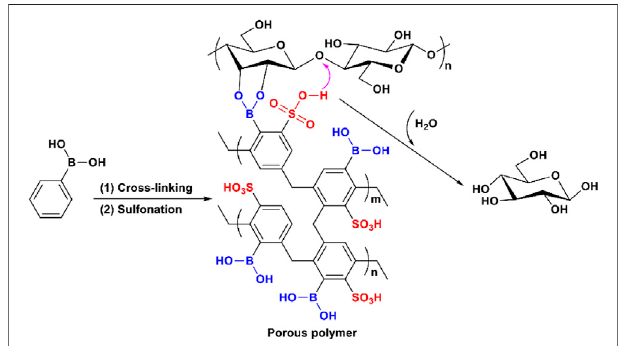
FIGURE 6 | Proposed cellulose hydrolysis mechanism for the cellulase- mimetic catalyst bearing boronic and sulfonic acids on porous polymer.